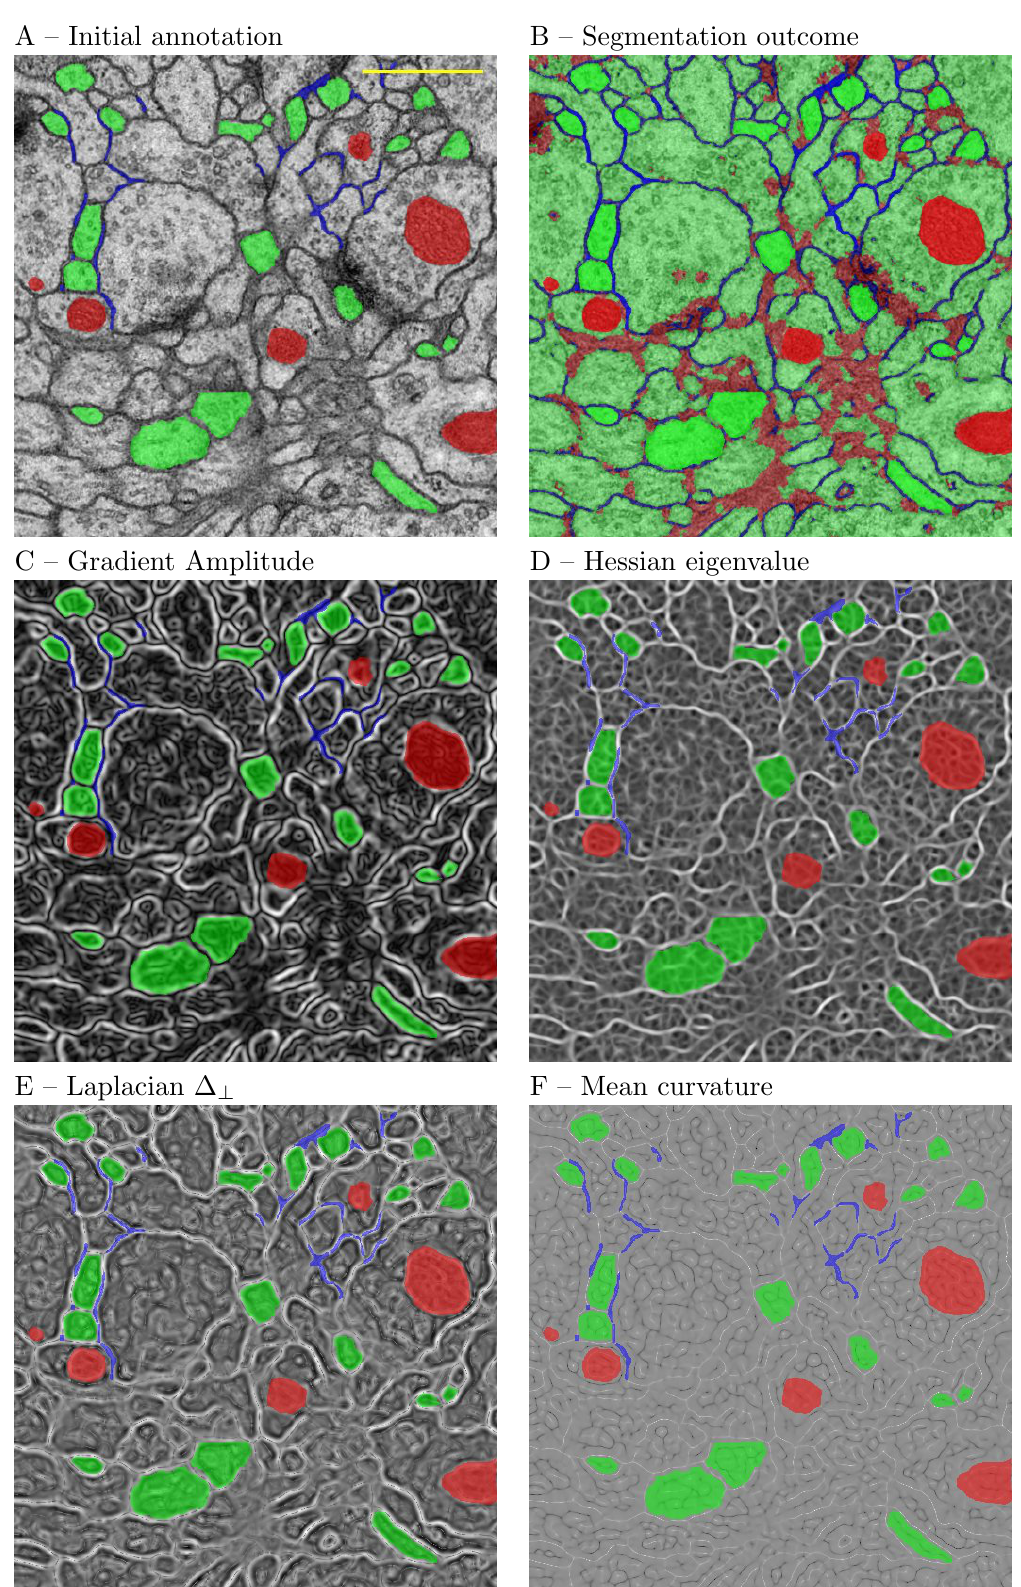
Figure 8. Characteristic features compared to the segmentation outcome. ( A ) Initial expert annotation. ( B ) Outcome of the segmentation; ( C ) Gradient amplitude, r = 8; ( D ) Largest Hessian eigenvalue, r = 8; ( E ) Normal component ∆ r = 8; ( F ) Mean curvature, r = 8. The scale bar represents 0.5 µ